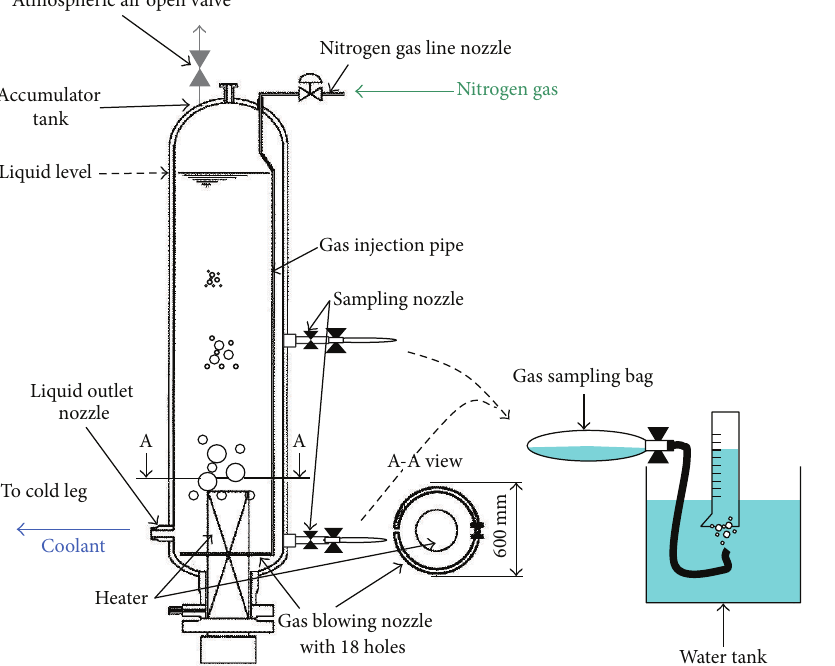
Figure 4: Schematic view of LSTF accumulator tank and associated apparatus for measurement of dissolved nitrogen gas concentration.